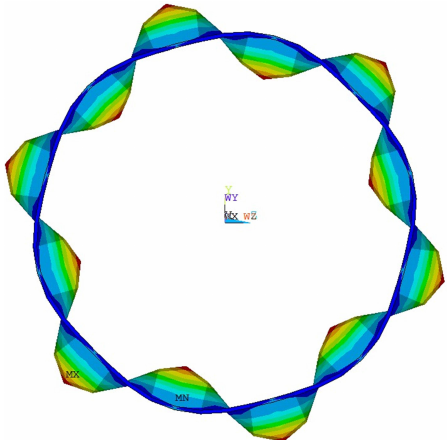
Figure 19. First and second verification model. SOLID5 and SHELL181 are employed for piezo and cylinder, respectively. The transducer is used as an actuator when voltage is applied, and a sensor when force is applied.